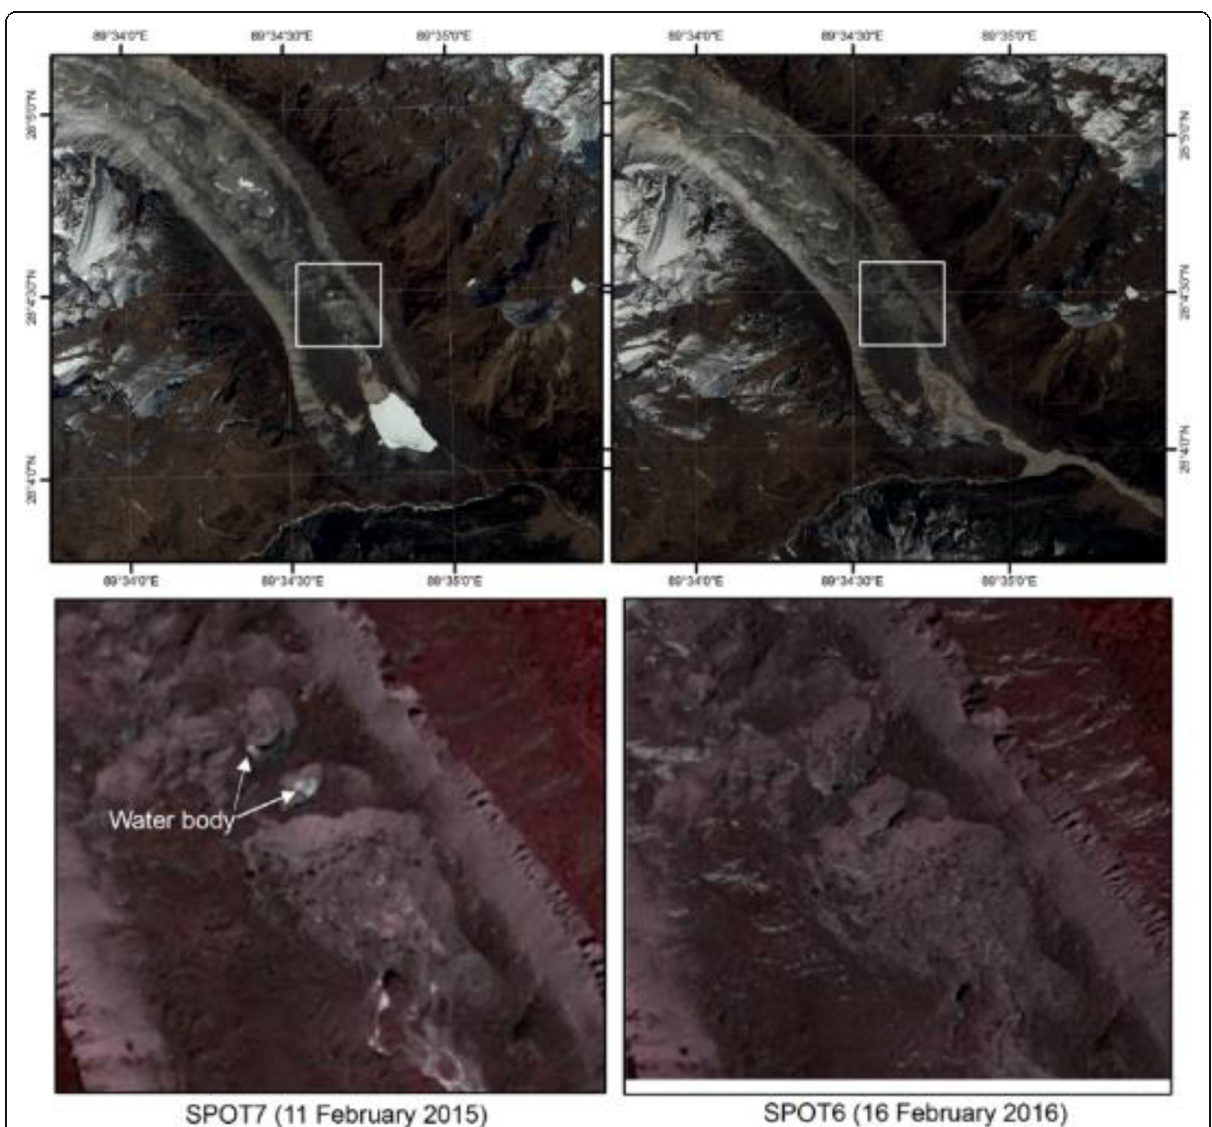
Fig. 4 Pre ( left ) and post ( right ) GLOF event SPOT images of Lemthang Tsho. Bottom images clearly show the emptying of two supraglacial ponds, which ultimately resulted in the